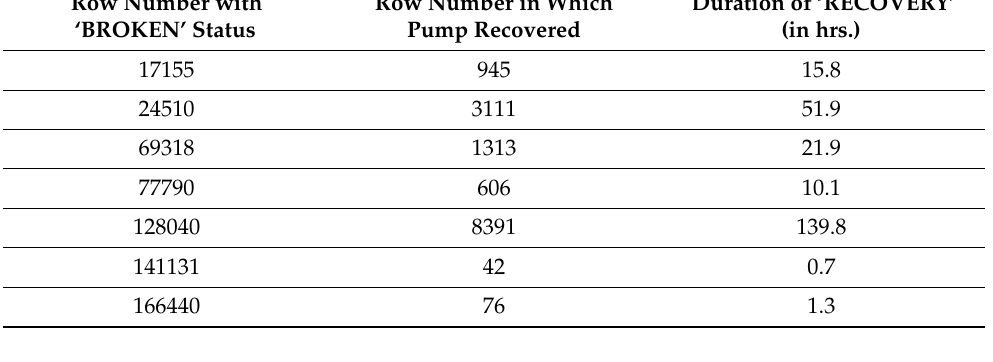
Figure 5. Exploratory data analysis.